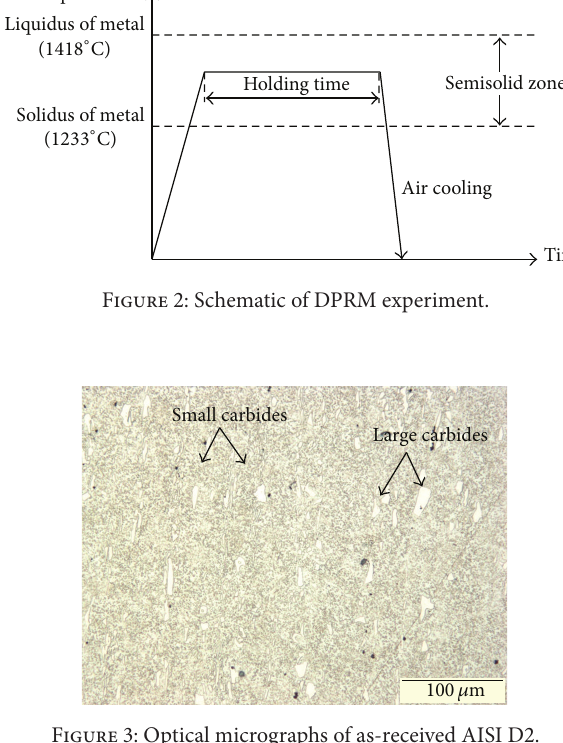
Figure 3: Optical micrographs of as-received AISI D2.